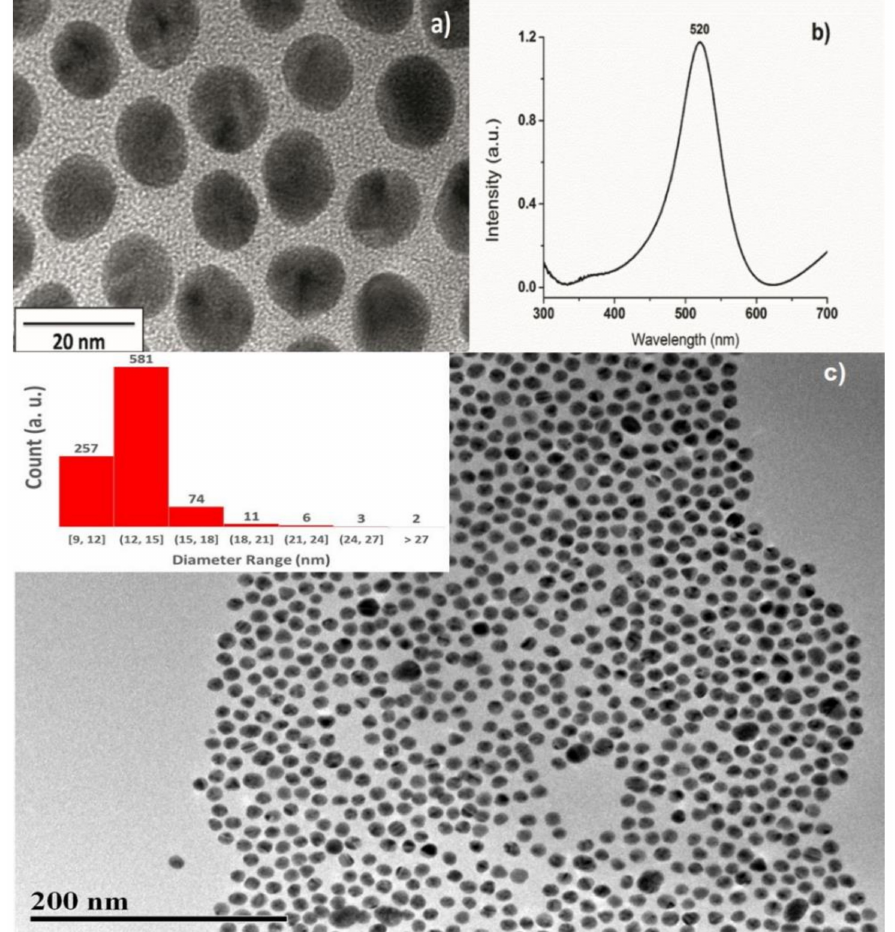
Figure 1. ( a ) High magnification TEM micrographs of gold nanoparticles; ( b ) absorption spectra of the gold nanoparticles; ( c ) TEM micrograph, inset shows the size distribution of gold nanoparticles. In order to evaluate the presence of the NPs at the cellular level, we acquired SEM micrographs of the carcinogenic cervix cells (Figure 2a,b) and cells with HPV